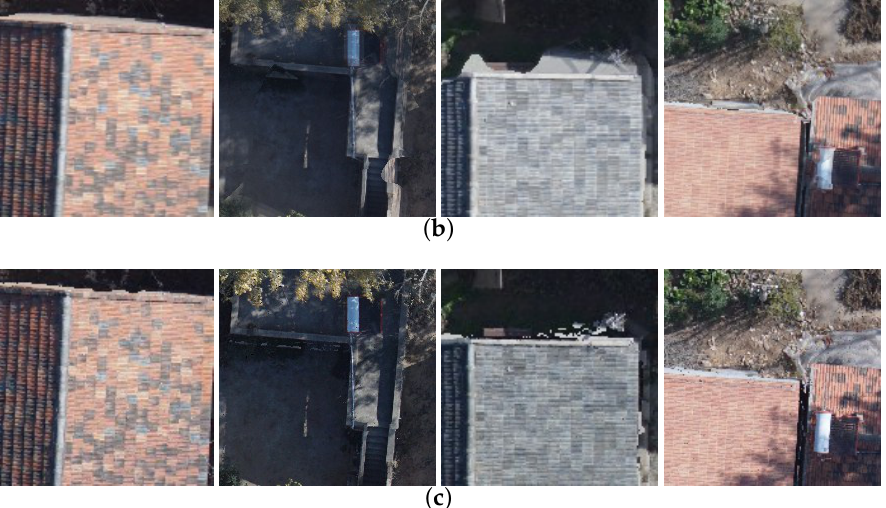
Figure 18. Detailed comparison between TDM and Pix4D in the digital orthophotos. ( a ) Four cropped small areas used for a detailed comparison. The numbers 1–4 correspond to the images from left to right in ( b ) and ( c ). ( b ) Details of Pix4D digital orthophoto. ( c ) Details of TDM digital orthophoto